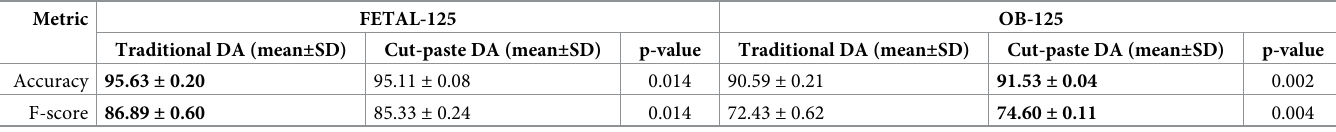
Table 5. Comparison of models trained with traditional and cut-paste data augmentation when application of augmentation during training time is balanced.